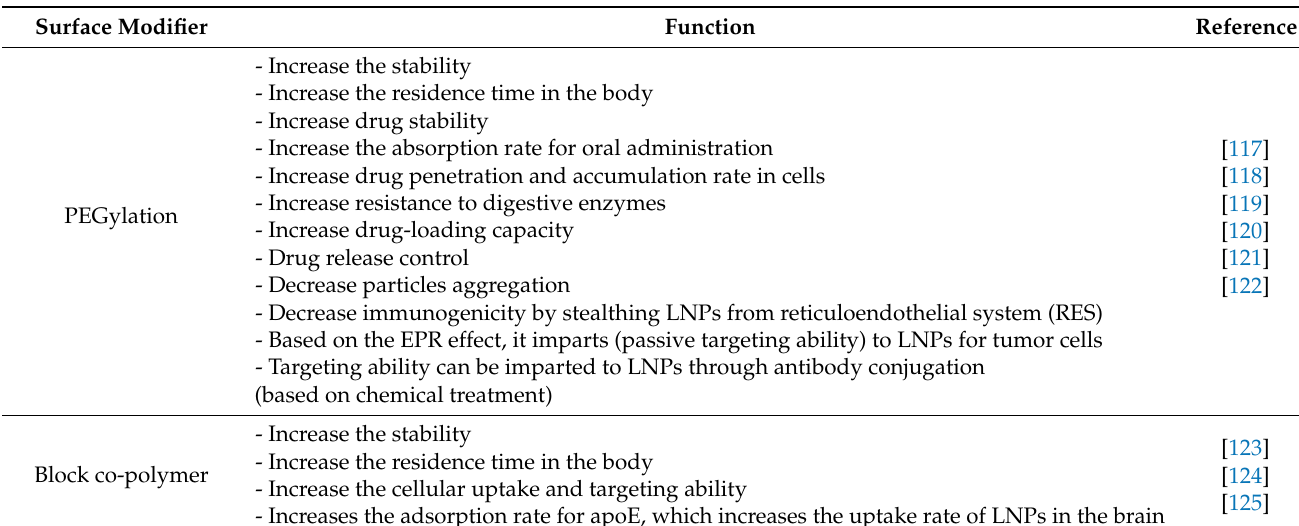
Figure 4. Various surface modifications for high-functionality of lipid nanoparticles. Table 2. Surface modification types and functions applied to